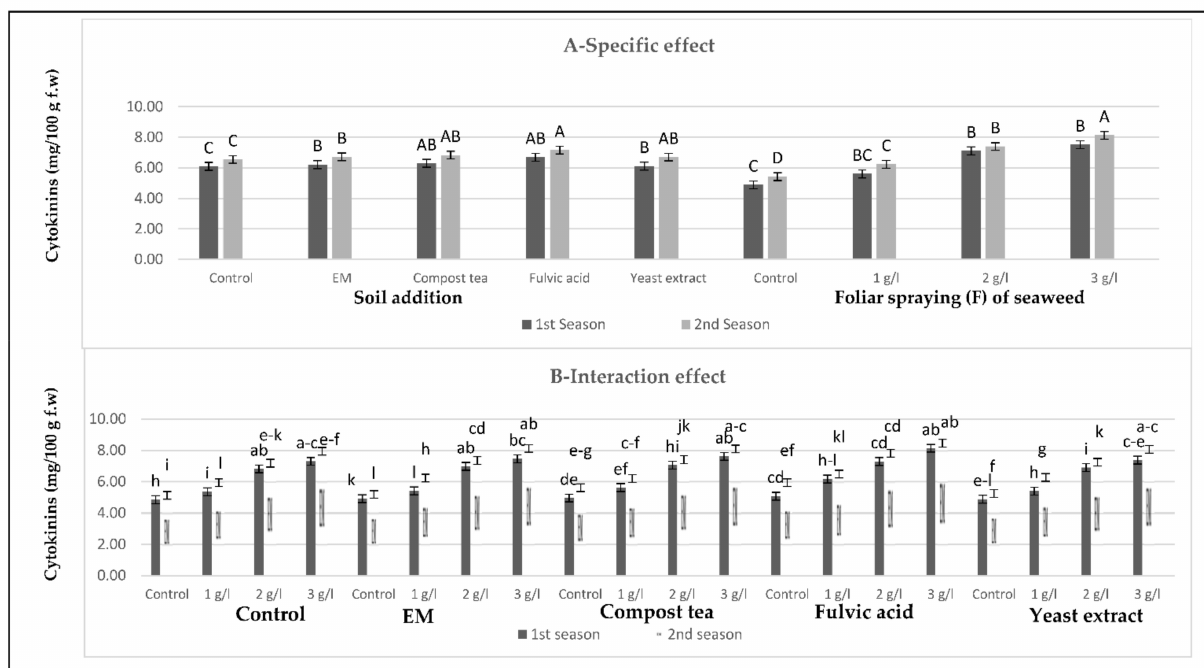
Figure 2. ( A , B ) Effects of soil addition of EM, compost tea, fulvic acid, yeast extract, and foliar spray with seaweed extract on the gibberellins (mg/100 g f.w) of sweet pepper plants during the 2019/2020 and 2020/2021 seasons. Specific effects are indicated with uppercase letters and the interactions are indicated with lowercase letters, unless otherwise mentioned, according to Tukey’s multiple range test (TMRT) at p ≤ 0.05.